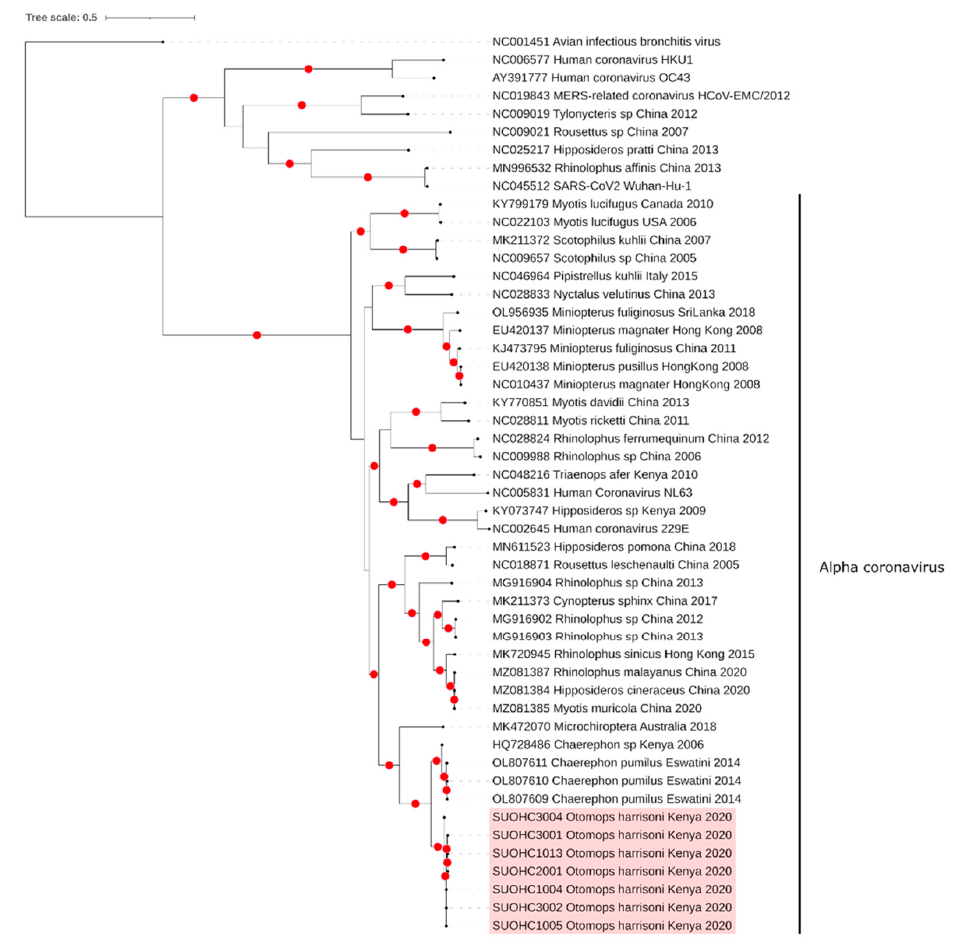
Figure 2. The Maximum Likelihood Consensus Tree Of The Coronavirus ORF1ab Sequences (8475 Nucleotides), Constructed Esing 1000 Replicates With Branches Achieving ≥ 95% Bootstrap Support Annotated By Red Dots.